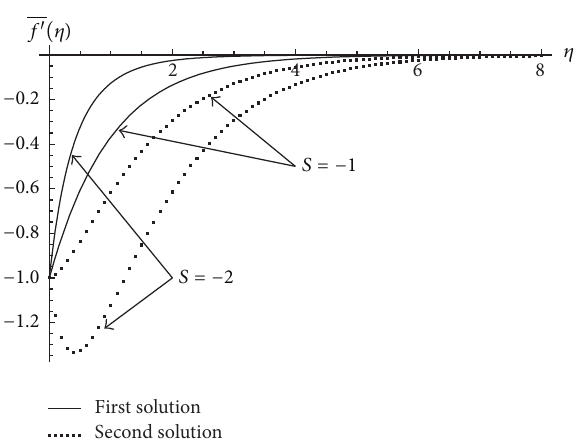
Figure 4: Velocity profile for different values of 𝑆 and 𝛾 = 1